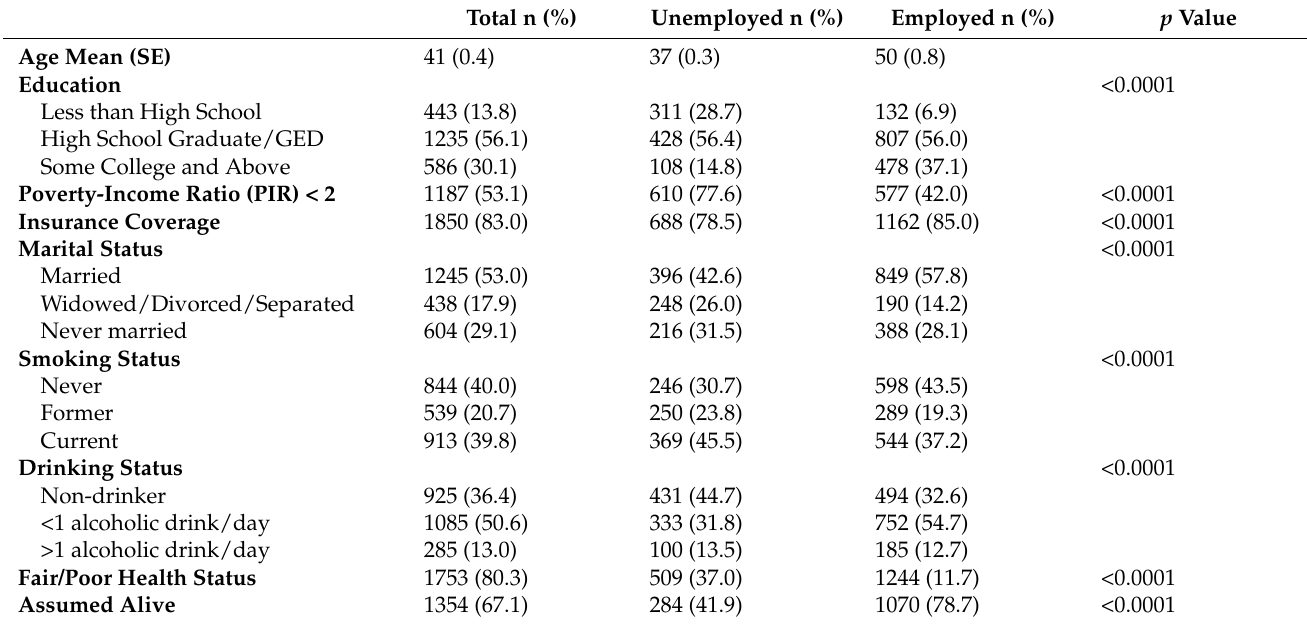
Table 1. Distribution of Select Baseline characteristics of Black men in the National Health and Nutrition Examination Survey III for the total sample and by employment status (n = 2300).